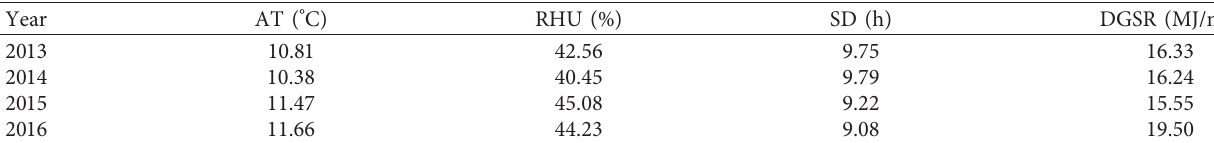
Figure 7: Scatter plots and MAEs of test samples. Table 3: Annual mean values of variables in test